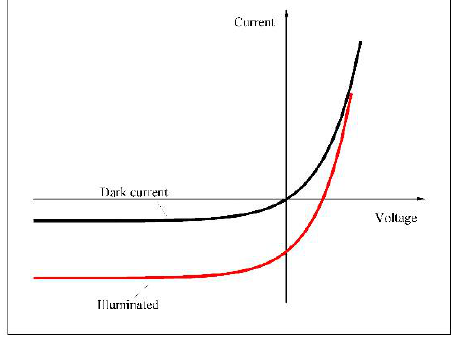
Figure 6. The I-V characteristic of a p-n photodiode.